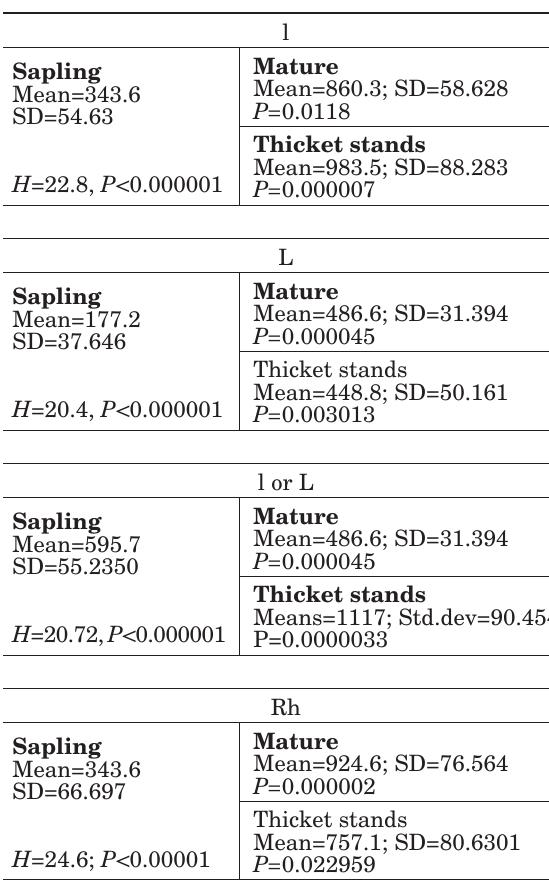
Table 2. Rectangular matrix of the correlation coefficients between “l”, “L”, “l or L”, “Rh” and Tmax, Tmin, Tmed and Prec, in each of the four sites (A, B, C, D). Signifi - cant values of the r Pearson Index are marked in bold ( P <0.05,